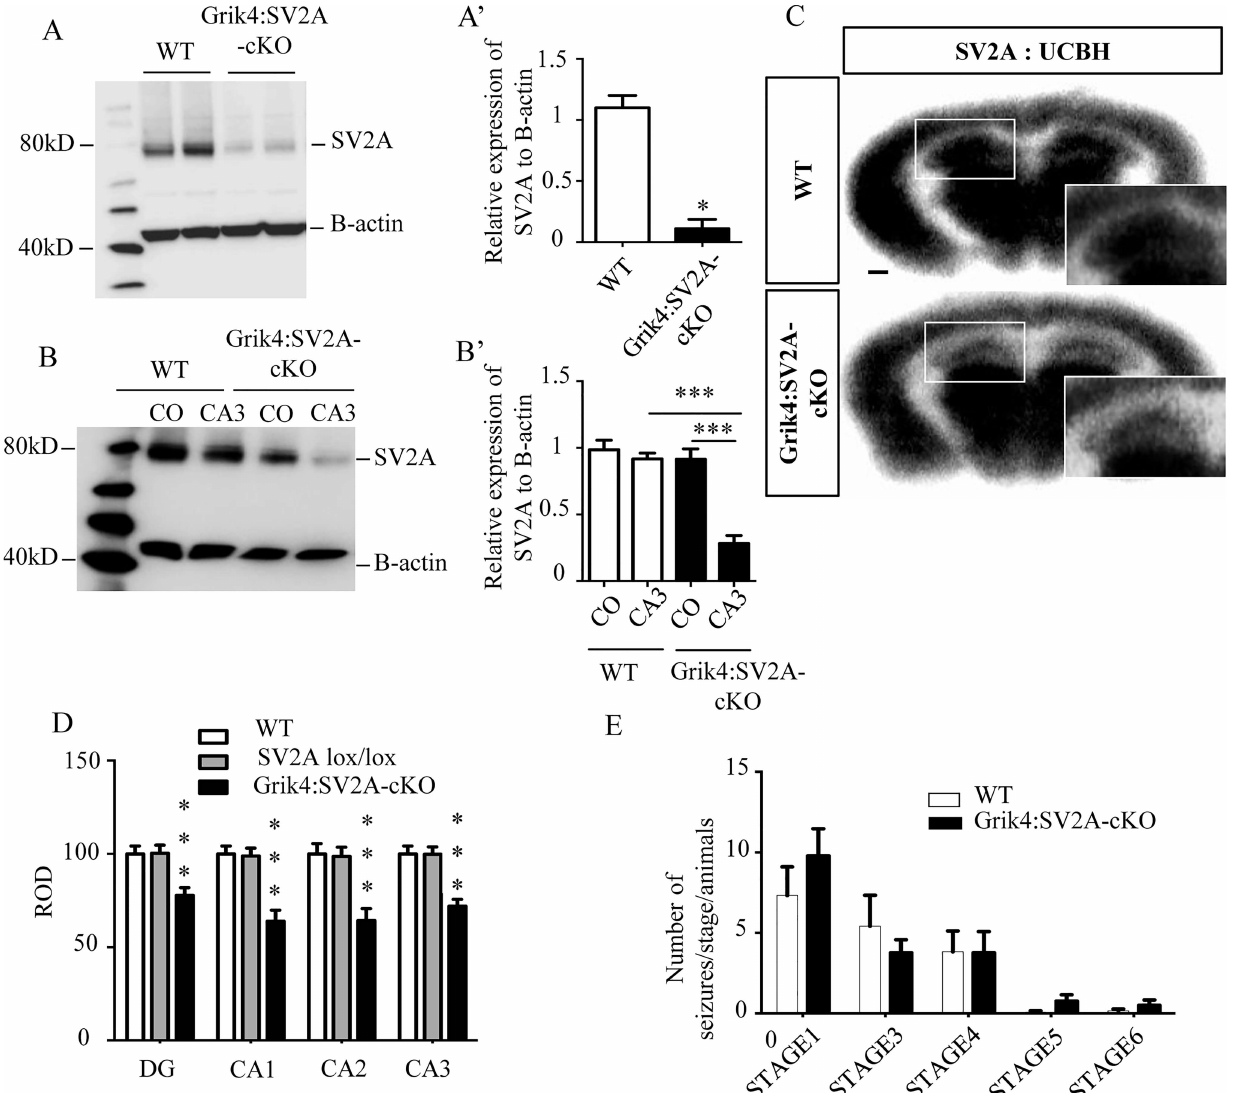
Fig 3. The absence of SV2A protein in the hippocampus does not lower the epileptic threshold. A: Western blot analysesrevealing SV2A protein depletionin the hippocampus of Grik4:SV2A-cKO mice in comparisonwith that of WTs. A’: Quantificationof the SV2A proteins extracted from the hippocampus of WT and Grik4:SV2A-cKO mice (n = 3/group, data presented as mean ± SEM, *** p < 0,001). B: Western blot analysesdemonstrating SV2A protein depletionin the cerebral cortex and CA3 of Grik4:SV2A-cKO mice comparedto WT. B’: Quantificationof the SV2A proteins (n = 3/group, data presentedas mean ± SEM, *** p < 0,001). C: Conditional removalof SV2A from adult mice CA3 areas validatedby using in vitro autoradiography with the radioligand 18 F-UCB-H (scale bar = 500 μ m).D: Semi-quantitation of 18 F-UCB-H signal intensity in the hippocampus (ROD: radioluminescence opticaldensity). E: Number of seizures per animal in those expressingdifferent behavioral categories post-PTZ injection: sudden behavioral arrest (Stage 1), facial jerking (Stage 2), neck jerks (Stage 3), clonic seizures (sitting) (Stage 4), tonic seizure(lying on belly) (Stage 5), tonic seizurewith wild jumping(Stage